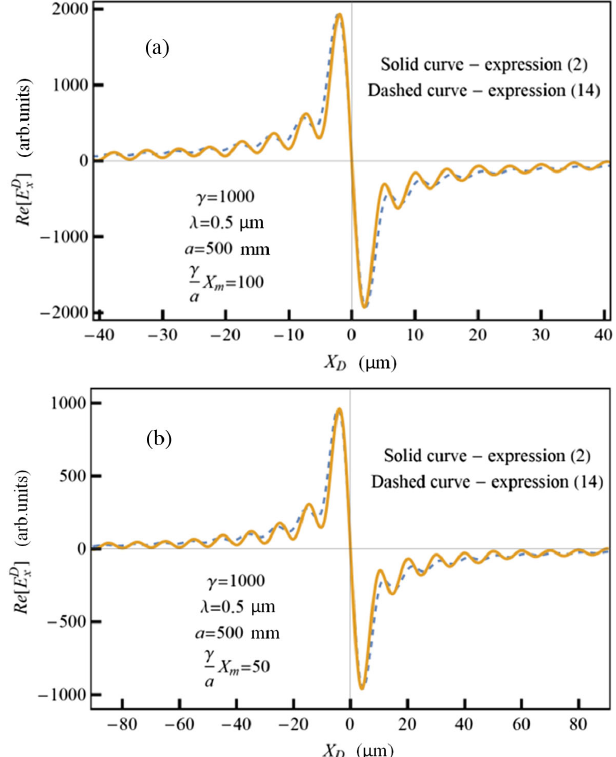
FIG. 7. Comparison of the analytical single particle OTR field approximation Eq. (14) and the exact expression Eq. (2) for two different lens apertures: (a) − 100 , (b) − 50 . The parameter set used for the calculation is shown in the